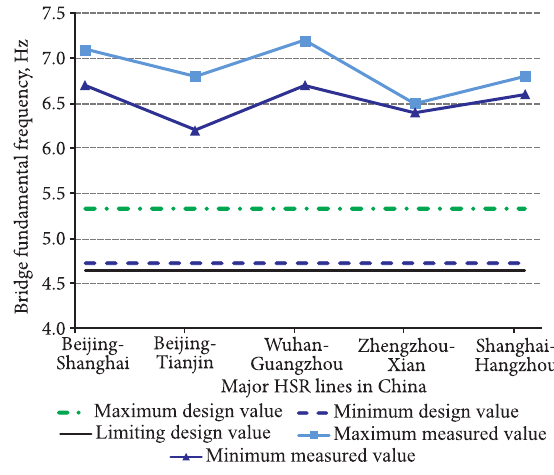
Fig. 8. Test and design natural frequencies of 32 m